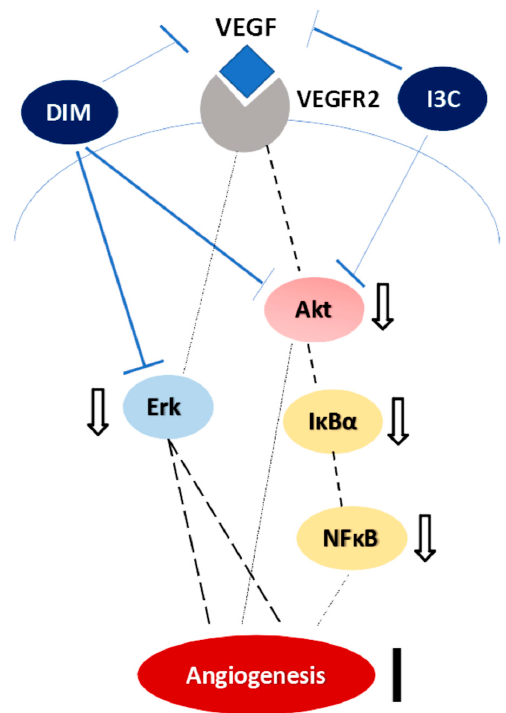
Figure 6. The angiogenesis-related signaling pathways influenced by I3C and DIM in mesentery of rats with CBDL-induced liver cirrhosis. The dashed line denotes the down-regulated signaling transduction, the solid line indicates the blocked angiogenesis, and the t-bar represents the direct inhibitory actions of I3C and DIM on the targets.